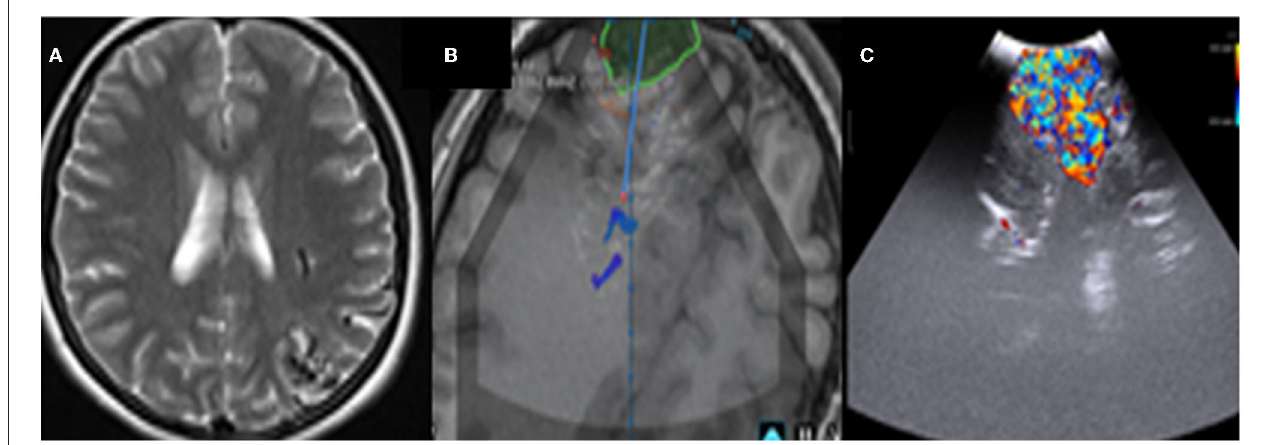
FIGURE 8 | (A) Pre-operative MRI depicting an occipital arteriovenous-malformation (AVM). (B) Intraoperative ultrasound integrated with brain lab system clearly identifying the AVM. (C) Doppler mode.